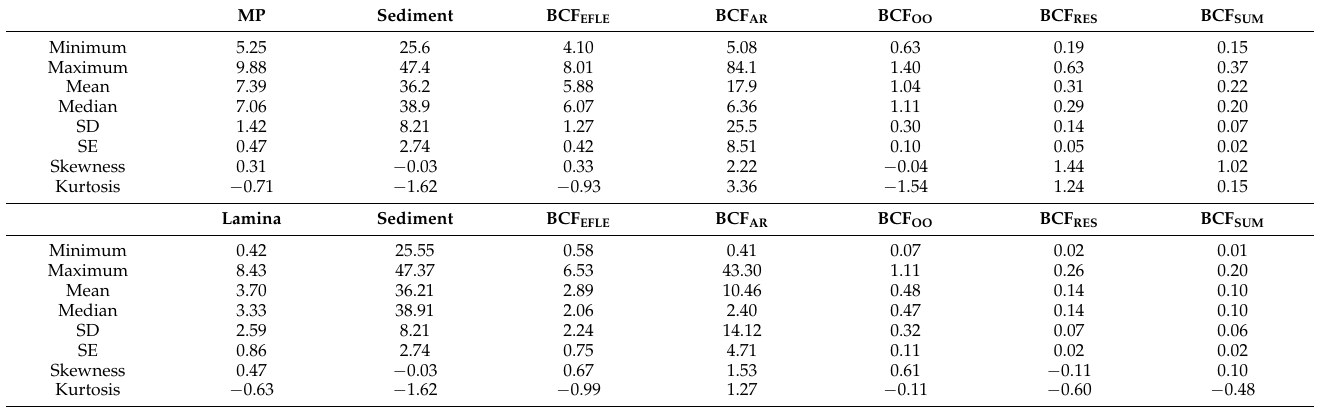
Table 5. Overall statistics of Pb concentrations (mg/kg dry weight) in the midrib plus petiole (MP) and lamina of Rhizophora apiculata , with their habitat geochemical fractions of sediments and their bioconcentration factors (BCF) values, collected from nine sampling sites in the mangrove areas of Sepang and Lukut. N = 9.